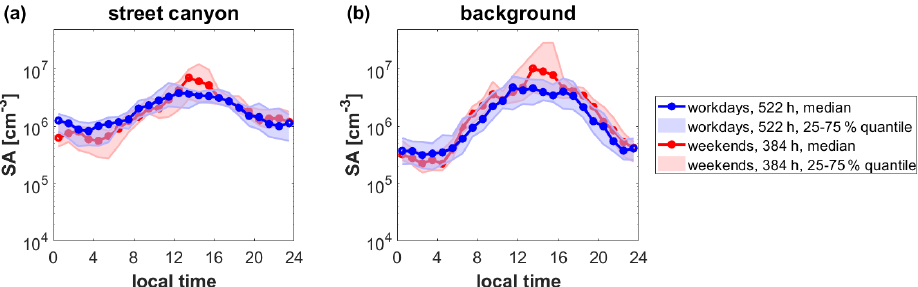
Figure 6. The diurnal variation of sulfuric acid (SA) concentration (a) at the street canyon and (b) at the background station. The median diurnal variation is shown as a solid line with markers; the 25th and 75th percentiles are presented as a shaded